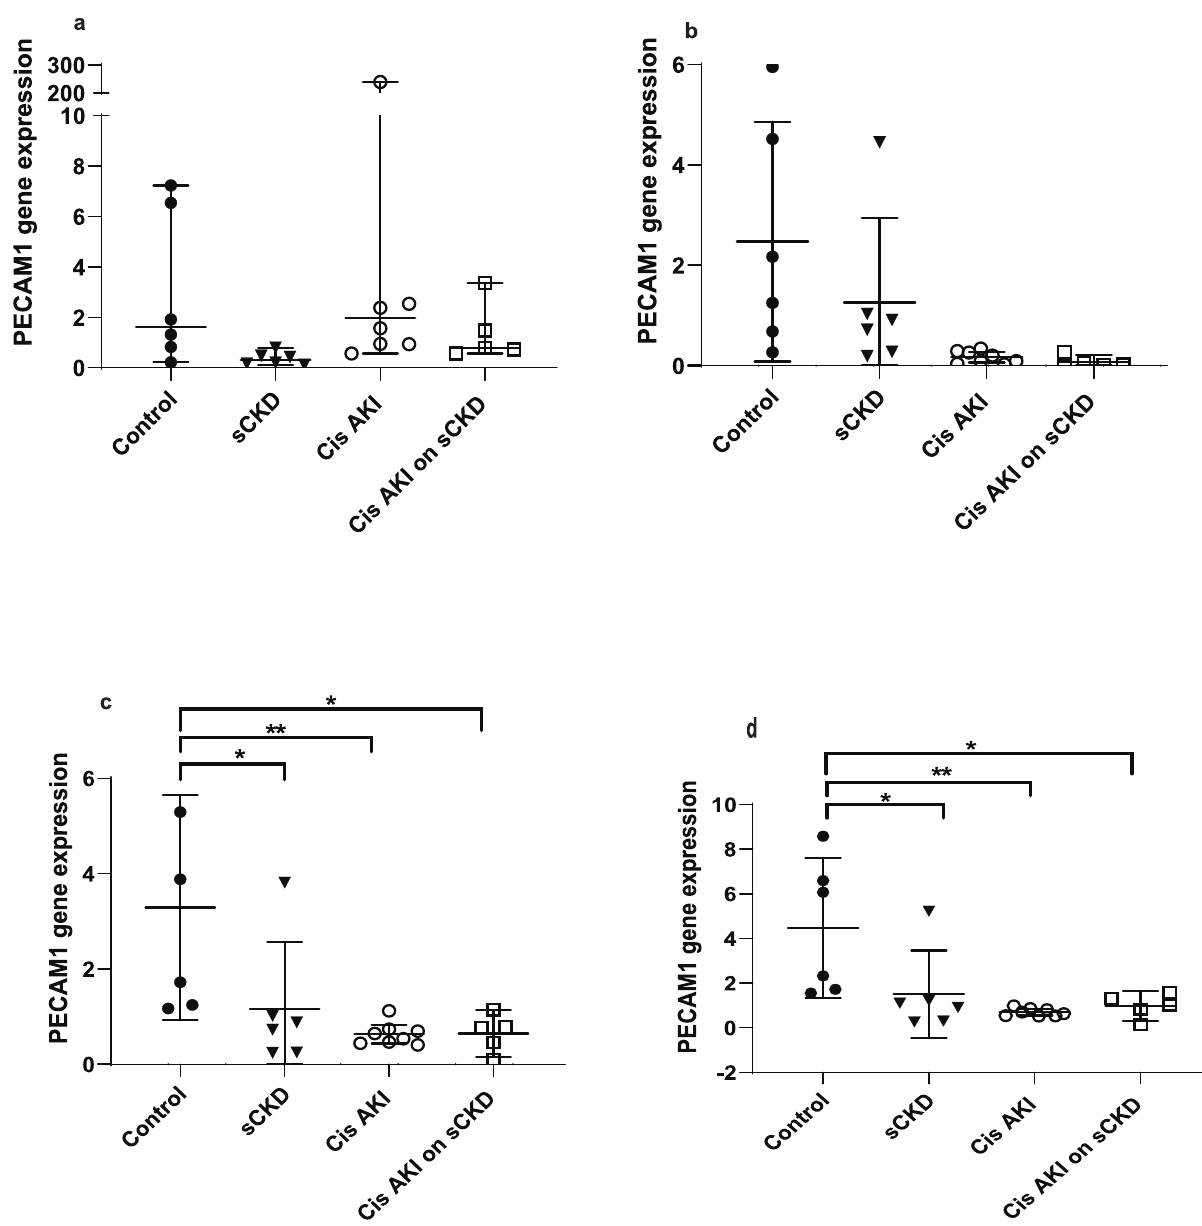
Fig 4. Expression of PECAM1 normalised to a) 18S , b) GAPDH , c) PABPN1×HMBS , d) ACTB×PABPN1 in the cisplatin treated groups. Data are means (one-way ANOVA) or medians (Kruskal Wallis) and 95% CI (n � 6). � p < 0.05, �� p < 0.01, ��� p < 0.001.